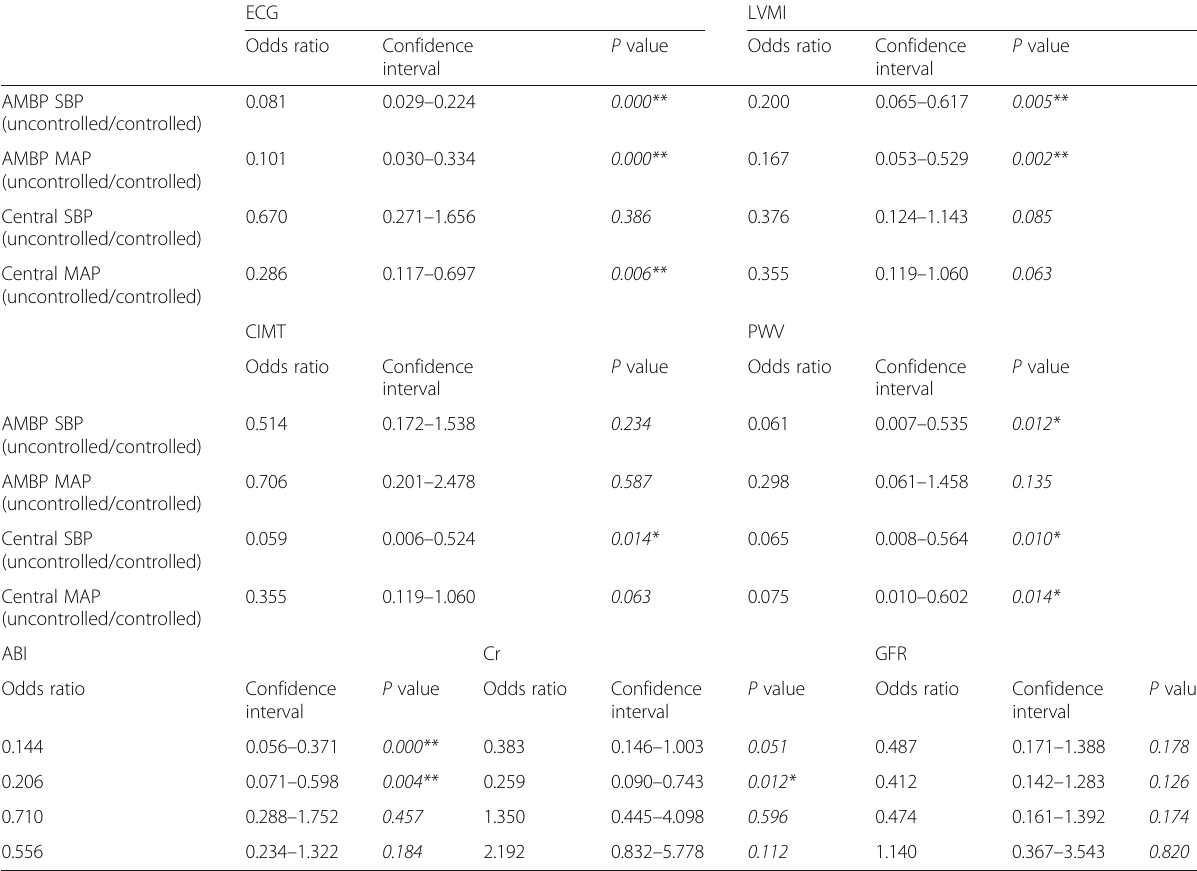
Logistic regression included the following independent variables: central SBP: uncontrolled = 1/controlled = 2; central MAP: abnormal = 1/normal = 2; ABPM SBP: uncontrolled = 1/controlled = 2; ABPM MAP: uncontrolled = 1/controlled = 2. Values in italics represent significant P value <0.05 ABPM ambulatory blood pressure monitoring, PWV pulse wave velocity, Cr creatinine, GFR glomerular filtration ratio, LVMI left ventricular mass index, CIMT carotid intimal thickness, ABI ankle-brachial index *Statistically significant difference ( p < 0.05) **Highly statistically significant difference ( p <